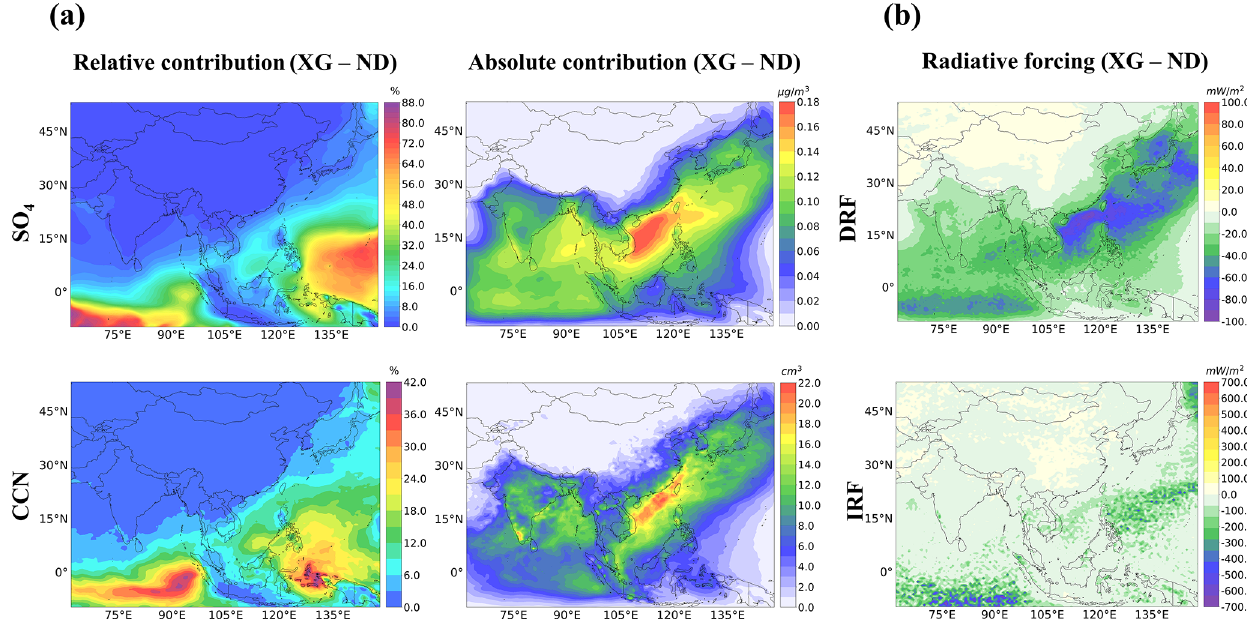
Figure 8. Panel (a) presents the spatial distributions of annual mean percent changes and absolute changes in surface SO 42 − and CCN, and panel (b) presents the spatial distributions of annual mean all-sky DRF and cloud-albedo IRF between XG and ND (no DMS)